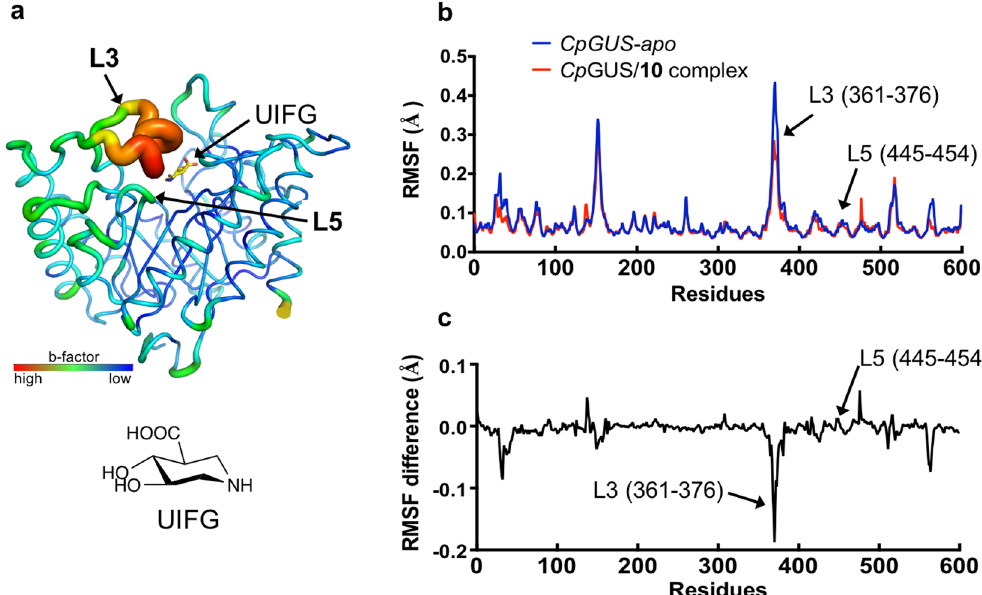
Figure 5. Loop 3 provides necessary flexibility in the ABS of bacterial GUSs. ( a ) The B-factor putty image of the TIM barrel domain of the Rg GUS/UIFG complex and the molecular structure of UIFG. The relatively large B-factor of loop 3 in Rg GUS indicates a large degree of flexibility. ( b ) The RMSFs of the C α atoms of apo Cp GUS and the Cp GUS/ 10 complex are shown for 20-ns MD simulations. ( c ) The differences in the RMSFs were calculated the C α atoms in apo Cp GUS and the Cp GUS/ 10 complex. Loop 3 is the most mobile loop in apo Cp GUS and the Cp GUS/ 10 complex. The RMSF difference of the two forms of Cp GUS suggests that the flexibility of loop 3 decreased upon substrate binding. Although the C α atoms of Cp GUS loop 5 seem mobile, side-chain movements of loop 5 residues were observed during the MD